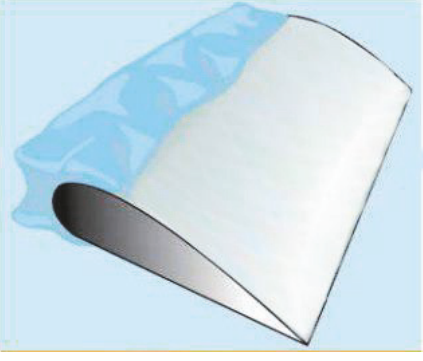
Figure 1: Double-horn glaze